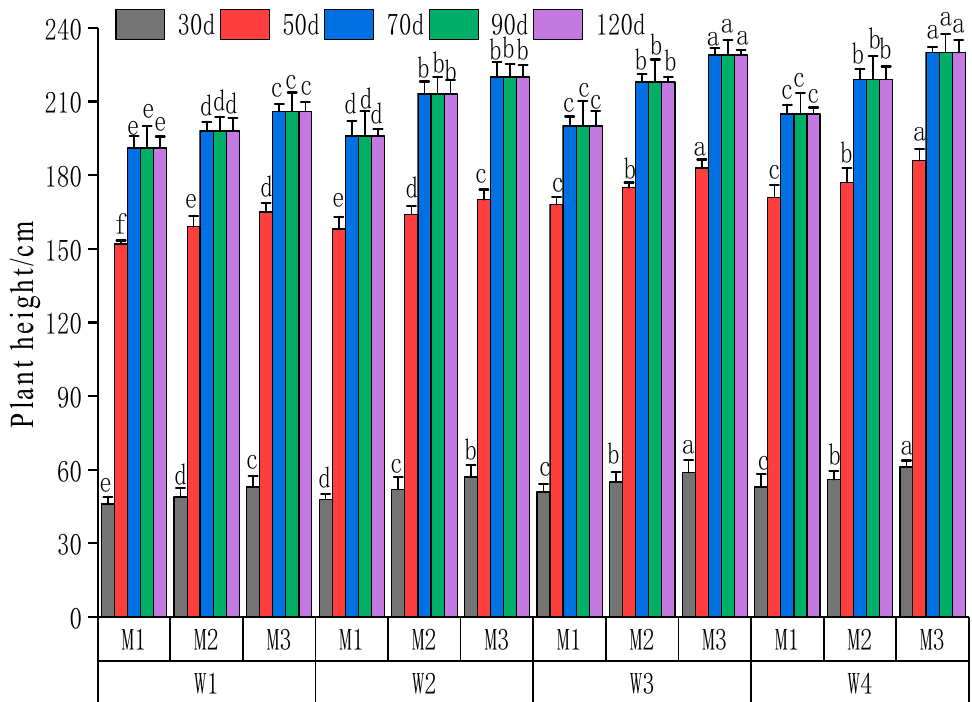
Figure 4. Variation of irrigation amount on plant height of degradable film-covered drip-irrigated maize. Note: 30 d, 50 d, 70 d, 90 d, 120 d represent the number of days after emergence of corn; different lowercase letters, respectively, indicate p < 0.05 difference, and the error line in the figure indicates standard deviation; the same below.